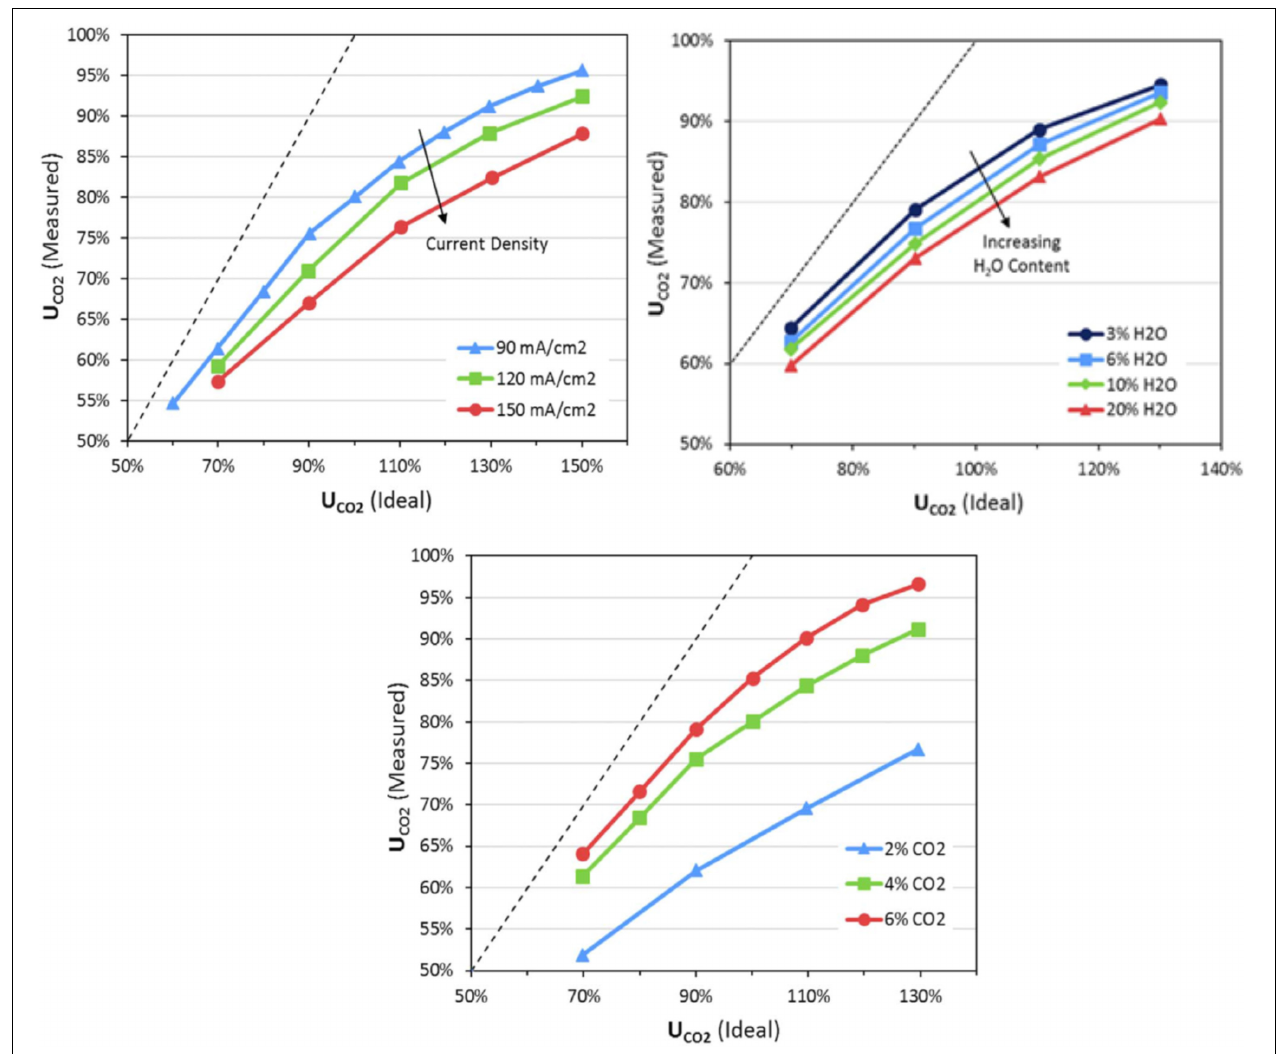
FIGURE 4 | Plots of measured CO 2 utilization rate versus expected, for various current densities, water contents, and CO 2 contents (Rosen et al.,